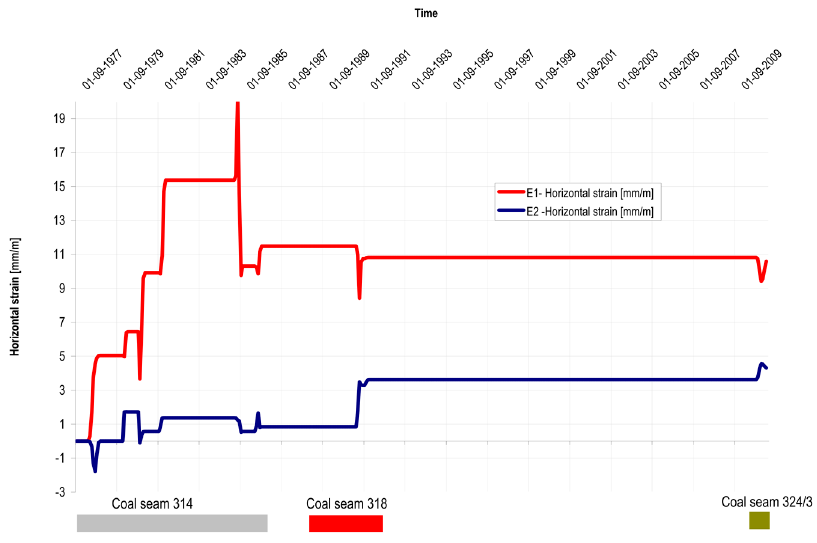
Figure 14. The course of the principal horizontal strain (E1, E2) at the location of the discontinuous deformation over time.